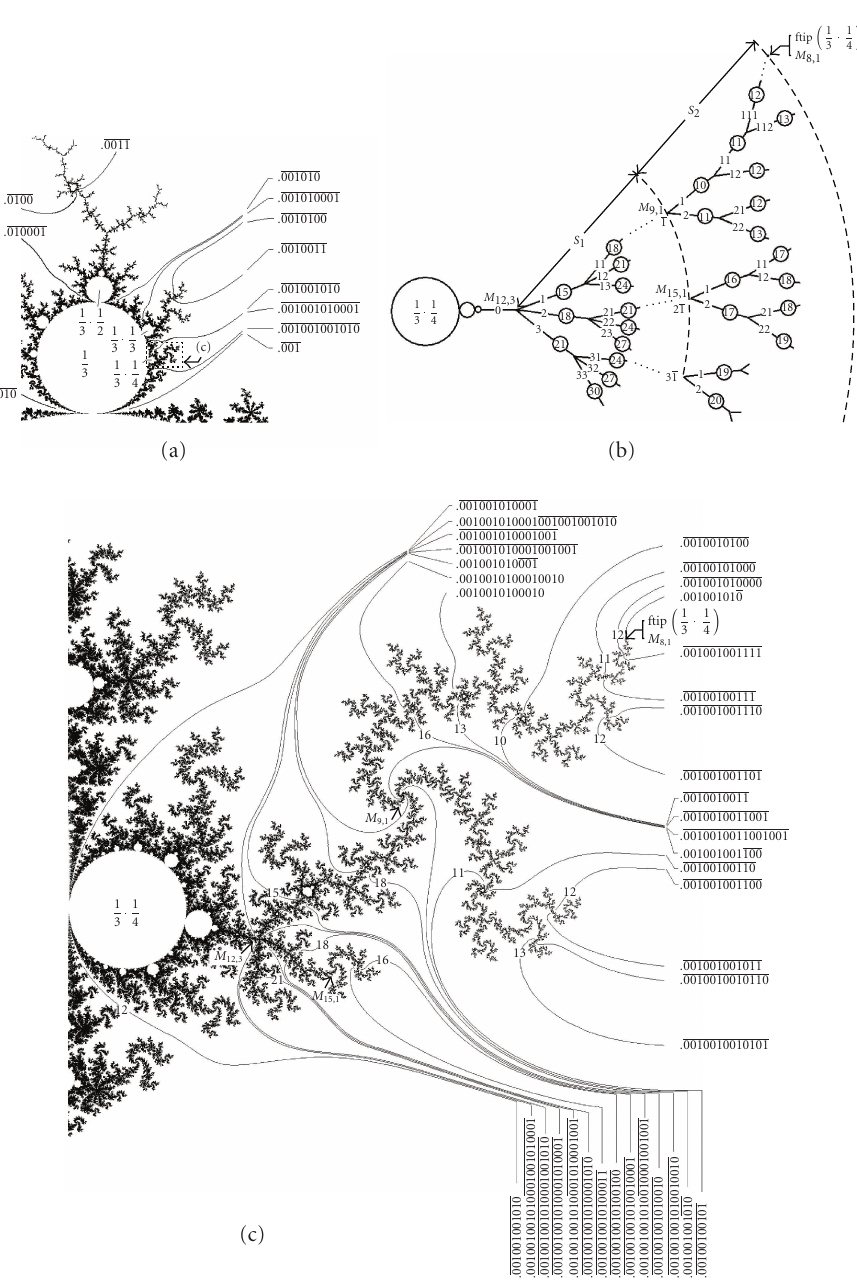
Figure 2.3 . (a) A detail of the neighborhood of the primary hyperbolic component 1/3, where some external arguments and shrubs are shown. (b) Sketch of a secondary shrub, shrub (1 / 3 · 1 / 4). (c) Mag- nification of the rectangle of (a) showing the shrub (1 / 3 · 1 / 4). The external arguments of some notable components and Misiurewicz points are